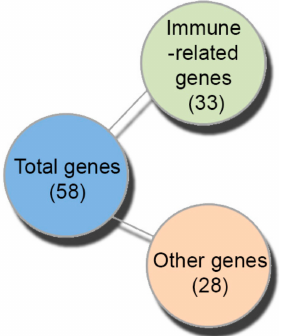
Figure 2. Schematic representation of gene expression data of zebrafish fed with mastic essential oil diet. Table 2. Di ff erentially expressed immune-related genes in zebrafish upon dietary supplementation with mastic essential oil. Genes were categorized by a selection criteria of fold change ≥ 1.7 and p -value < 0.05 in treated versus control zebrafish. FC (abs): Fold Change